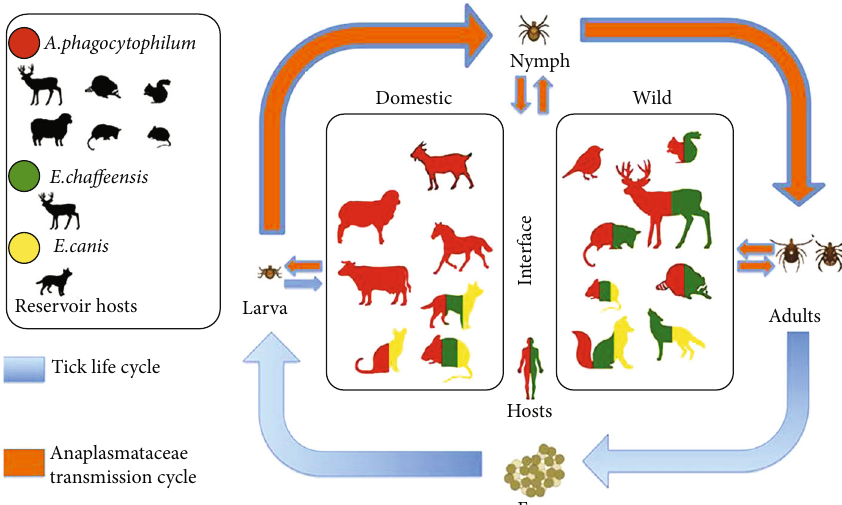
Figure 2: Tick-borne pathogen transmission. This image shows the life cycle of Ehrlichia species and which animal di ff erent tick-borne pathogens can inhabit. This also shows the di ff erent ways humans can come in contact with ticks. Image courtesy of the open access article by Rojero-Vázquez et al.